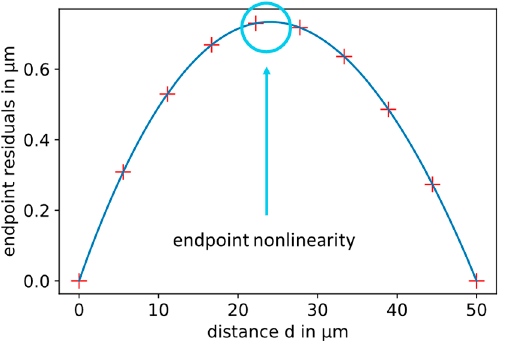
Figure 4. Residuals from the straight line (red crosses). The maximum residual is the endpoint nonlinearity, which is calculated by a fit (blue curve).